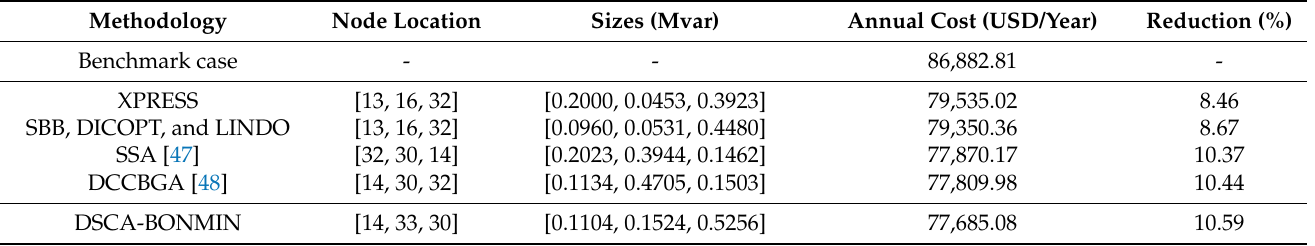
Table 8. Results obtained by the metaheuristic optimizers and the proposed methodology for the meshed